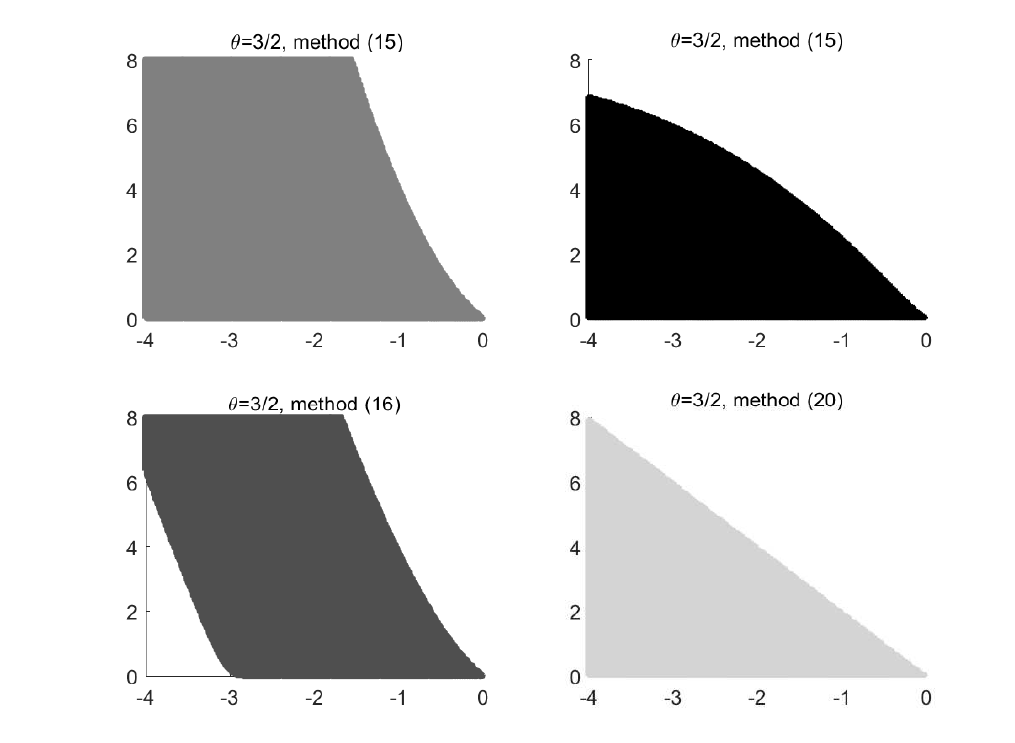
Figure 5. Mean-square stability regions in the ( x , y )-plane with respect to the basic test Equation (11), case ϑ = 3/2.